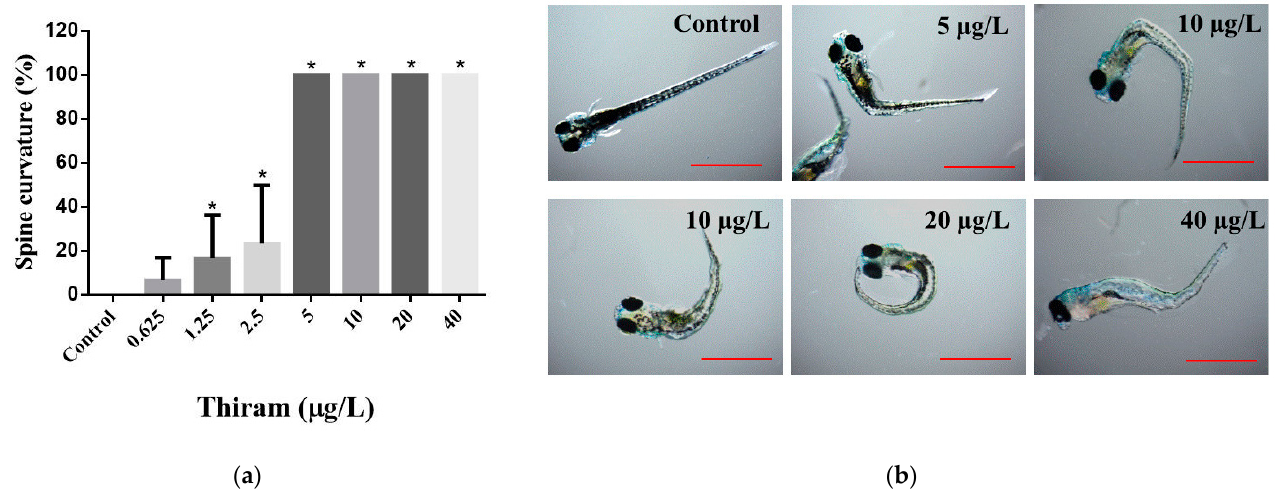
Figure 2. Spine curves of zebrafish induced at designated doses of thiram. ( a ) Graph shows the percentages of spine curves scored at 144 hpf. Data shown as mean ± SD were obtained from six plates (three independent experiments). Statistical differences were analyzed using an unpaired t -test; * p < 0.05. ( b ) Representative images showing thiram-induced spine curves at 144 hpf. Scale = 1.0 mm.